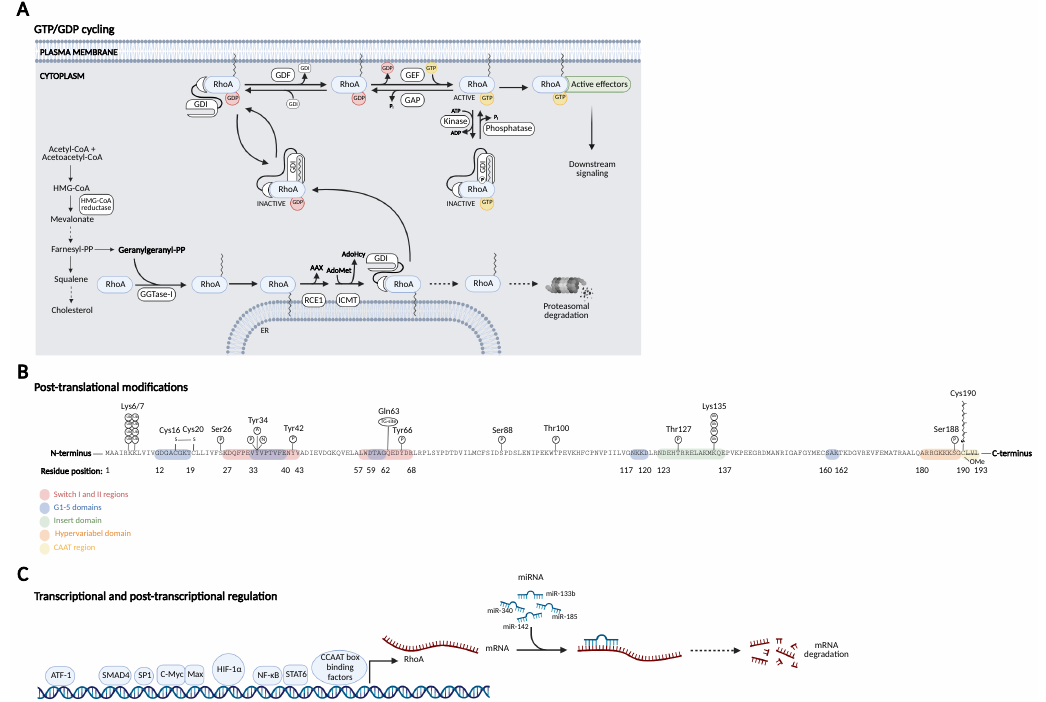
Figure 2. RhoA regulation. ( A ) RhoA cycle between an active GTP-bound conformation at the plasma membrane and an inactive GDP-bound conformation in the cytosol facilitated by prenylation and different regulatory proteins: guanine nucleotide exchange factors (GEFs), GTPase-activating proteins (GAPs), guanine nucleotide dissociation inhibitors (GDIs), and GDI displacement factors (GDFs).( B ) Post-translational modification events mapped onto the amino acid sequence of RhoA with highlighted locations of the functional protein domains from Figure 1. ( C ) Transcriptional and post-transcriptional regulation of RhoA showing known transcription factors and miRNAs regulating RHOA